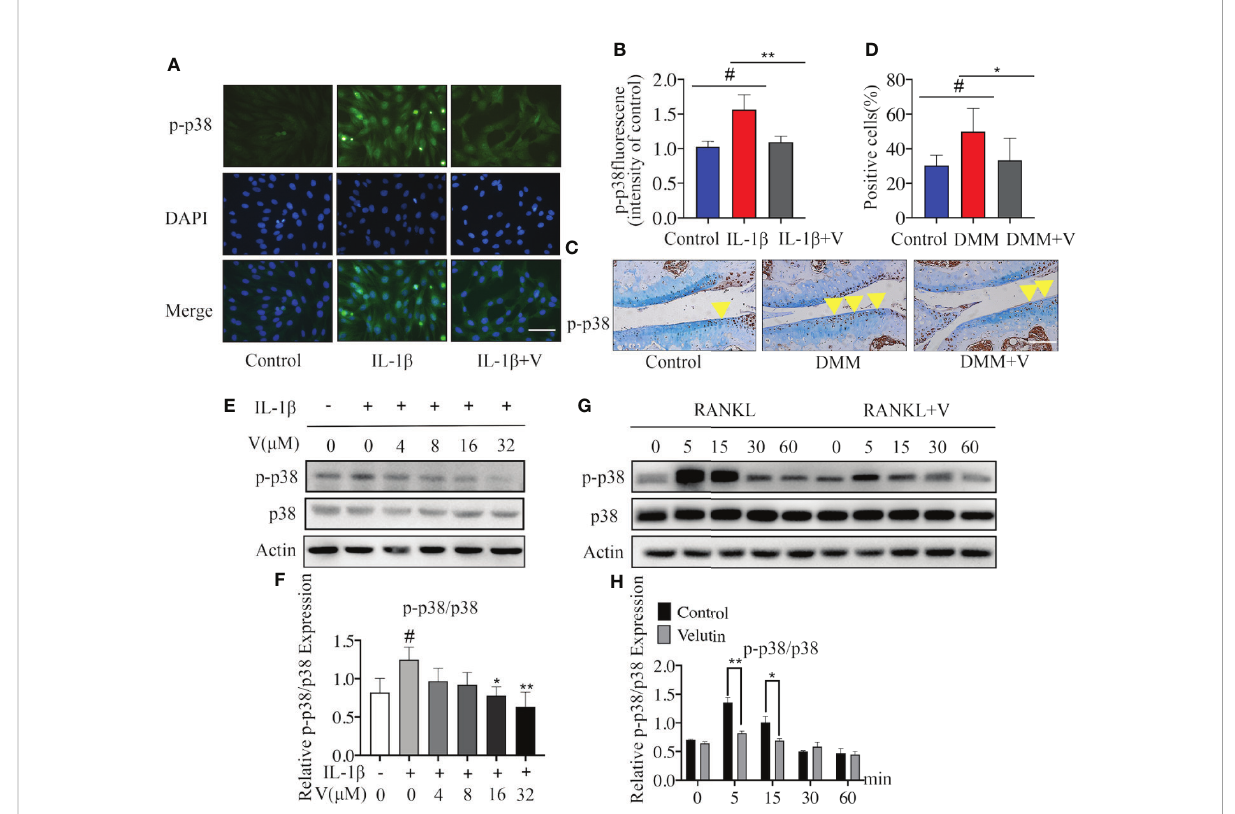
FIGURE 5 Velutin mediates its inhibitory effects through the p38 signaling pathway blockage. (A, B) Immuno fl uorescence DAPI nuclear staining showing that IL-1 b promoted the expression of p-p38, velutin treatment reversed this effect. (C, D) Immunohistochemical staining of p-p38 MAPK in cartilage and percentages of p-p38 MAPK positive cells; the yellow triangle indicates positive cells. (E, F) Chondrocytes were pretreated with velutin (4 m M) for 2 h, then stimulated with or without IL-1 b for 15 min. IL-1 b promoted p38 phosphorylation, while velutin reduced it in a dose- dependent manner. The expression of p-p38 MAPK relative to total p38 MAPK was determined by ImageJ software. (G, H) M-CSF-dependent bone marrow-derived macrophages (BMMs) were serum-starved and given velutin (4 M) or a vehicle control for 2 h before being activated with nuclear factor- k B receptor activator ligand (RANKL) for the indicated times (0, 5, 15, 30, and 60 min). RANKL promoted p38 phosphorylation, whereas velutin reduced in a time-dependent way. ImageJ software was used to calculate the expression of p-p38 in comparison to total p38. Data are presented as mean ± SD; * P < 0.05, ** P < 0.01, and *** P < 0.001, n =